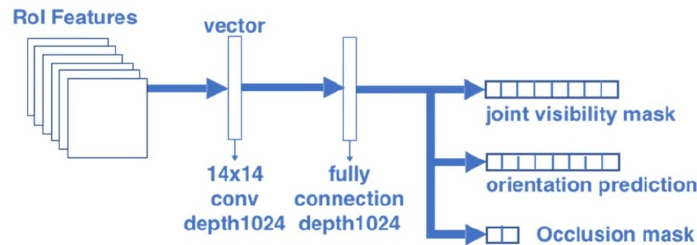
Figure 5. Architecture of the orientation-occlusion branch.